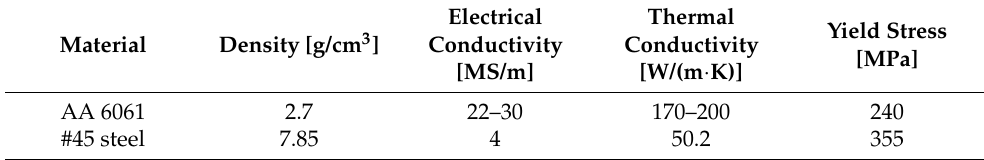
Table 1. Properties of the materials.